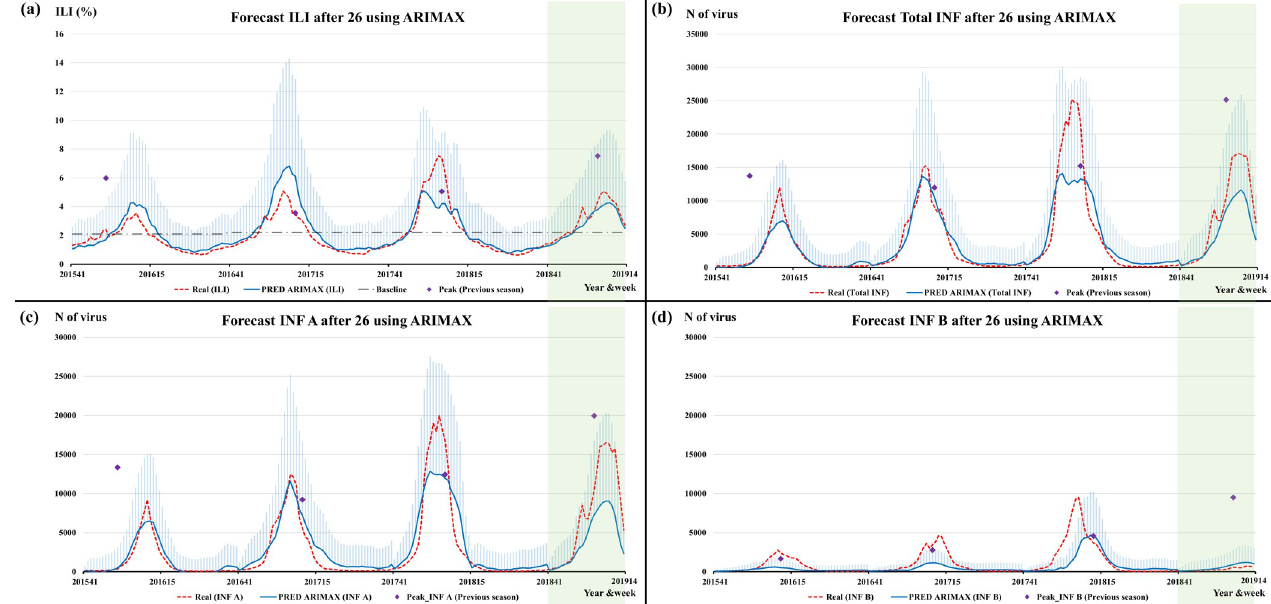
Fig 7. The prediction and 95% confidence interval of Auto Regressive Integrated Moving Average for ILI (a) and Total influenza (b), influenza A (c) and influenza B viruses (d) from 2015 to 2019 in the U.S.